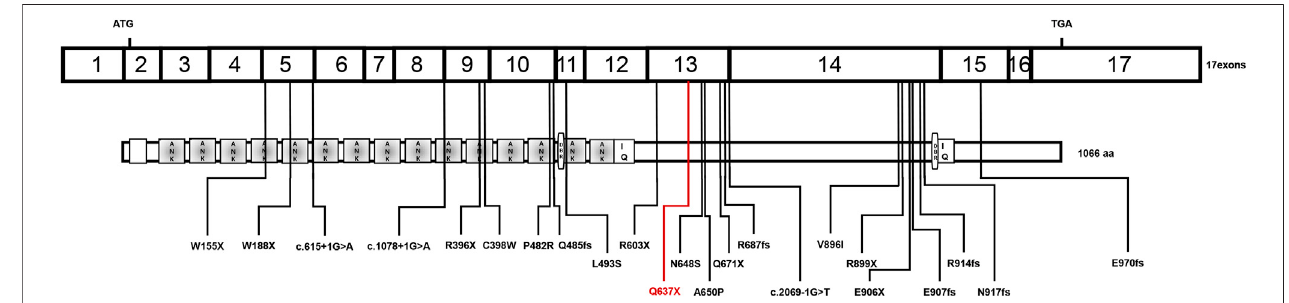
FIGURE 2 | Schematic diagram of the reported INVS mutations. ANK: ankyrin repeats, IQ: IQ calmodulin-binding domains, DBR: destruction box regions.